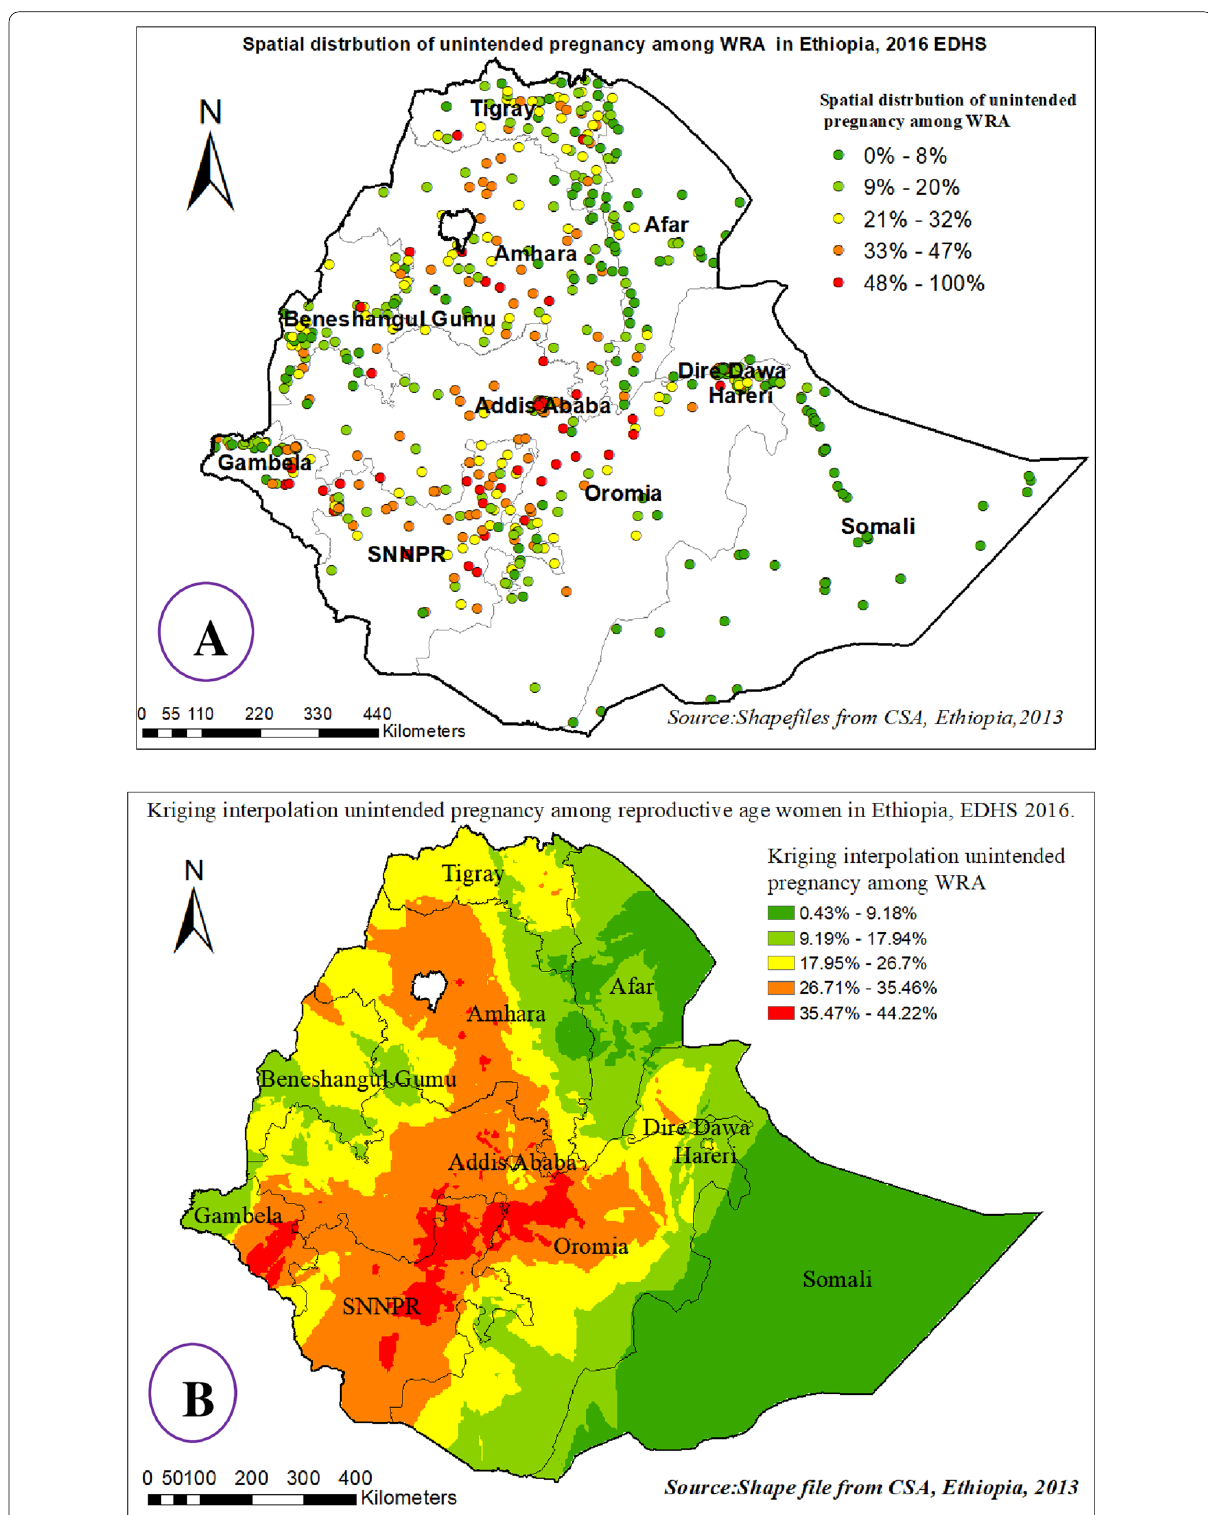
Fig. 4 Spatial distribution ( A ) and kriging interpolation ( B ) of unintended pregnancy among reproductive-age women in Ethiopia, 2016